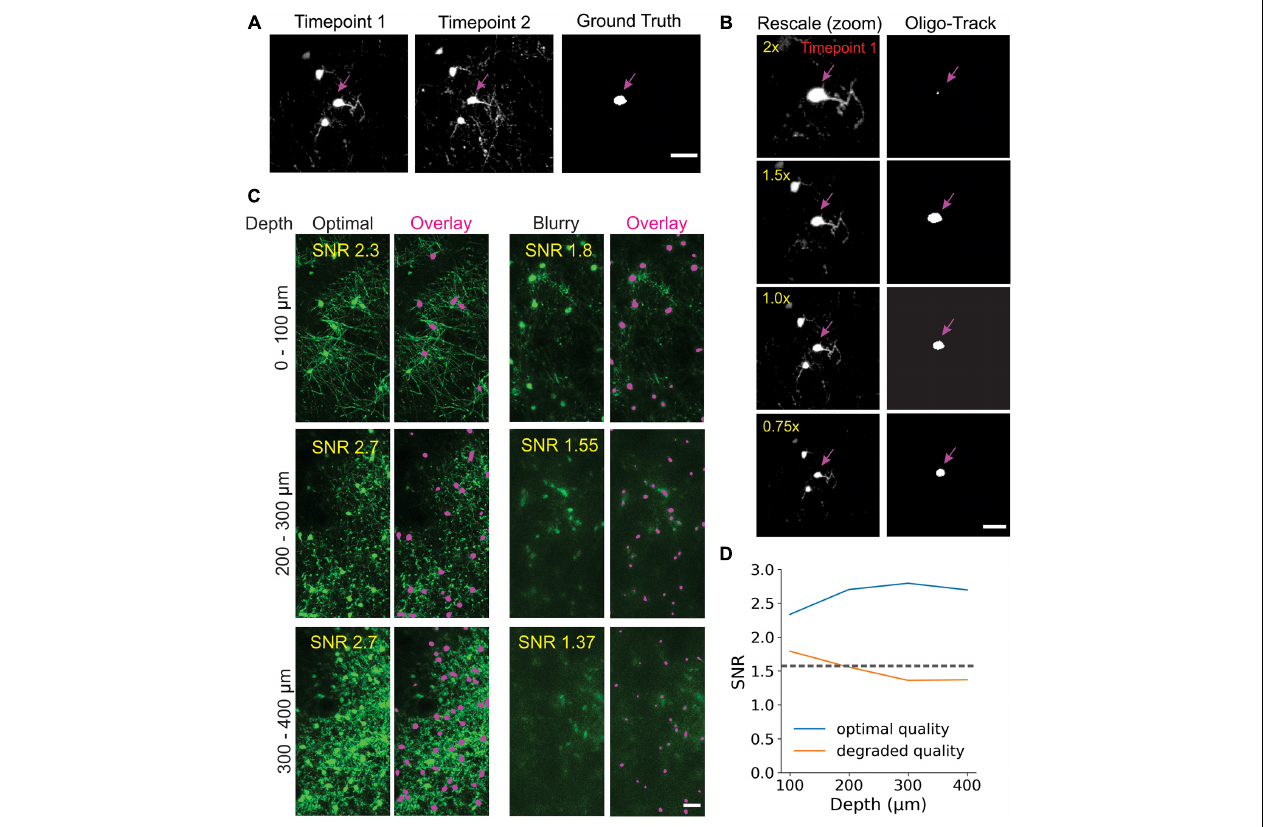
FIGURE 5 | Oligo-Track enables robust cell tracking under different experimental conditions. (A) Input image for Track-CNN used in (B) to assess impact of different rescaling on Track-CNN performance. Cell of interest denoted by magenta arrow. Scale bar: 30 µ m. (C) Representative XY maximum projections at indicated SNR values and depths in a volume with optimal image quality (left), and a volume with a less transparent cranial window (right). Overlay of cells detected by Oligo-Track in Magenta. Scale bar: 30 µ m. (D) Plotting average SNR across depth of optimal quality and degraded quality volumes. Dashed gray line indicates human perceptual limit for reliably tracing data. Also represents point at which algorithm will provide warning to